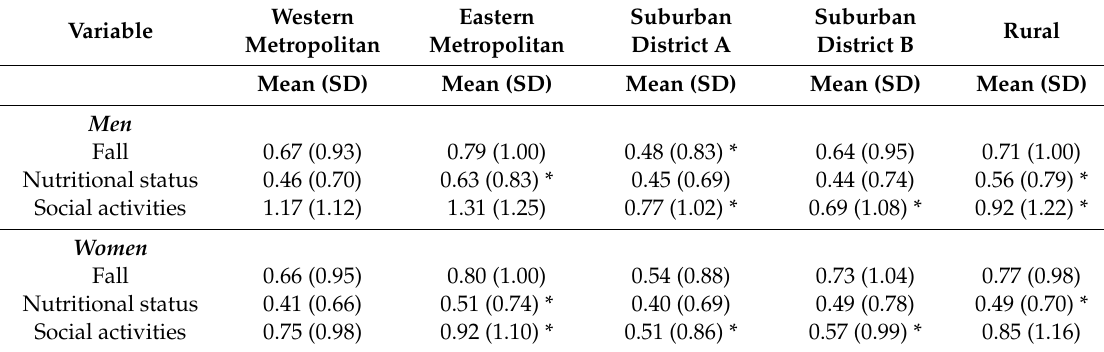
Table 3. Scores for Kaigo-Yobo Checklist (KYCL) subcategories in each area.